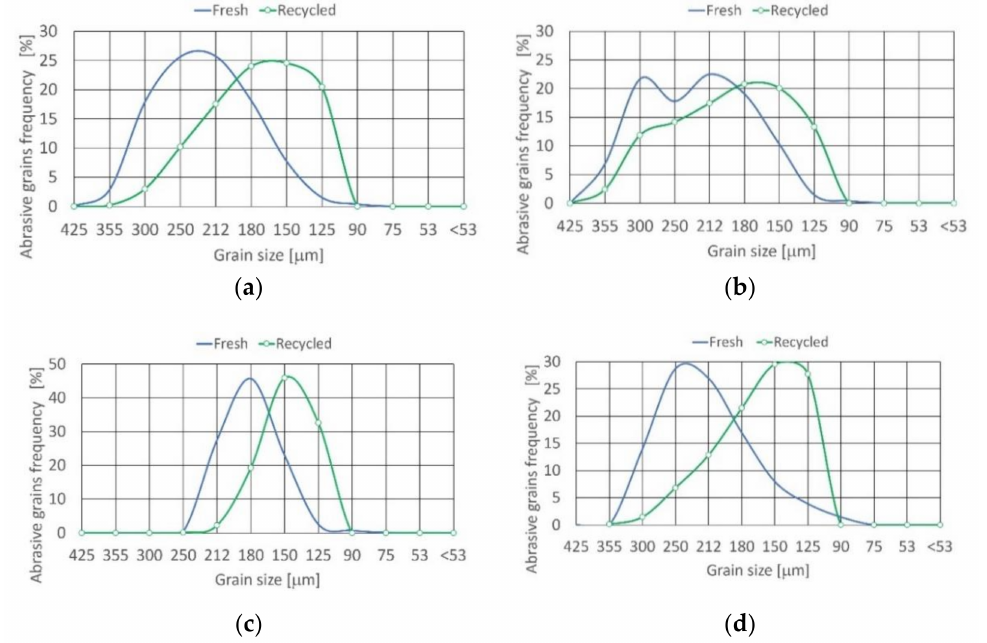
Figure 8. Size distribution of recycled abrasive materials: ( a ) alluvial garnet, ( b ) recycled garnet, ( c ) corundum, ( d )